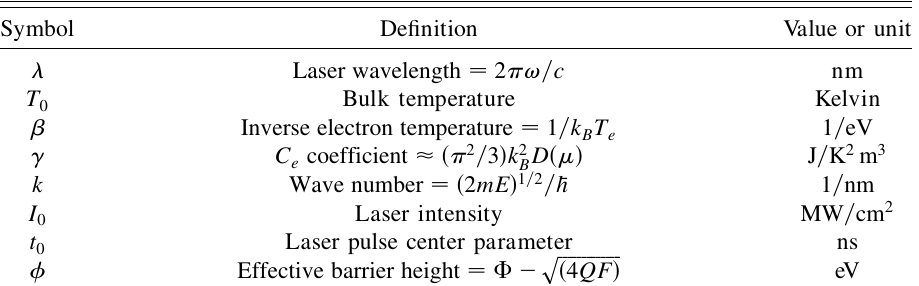
Symbols and units.